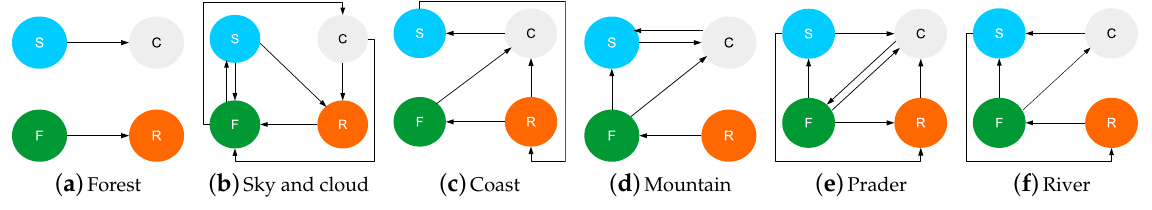
Figure 16. Evolutionary texture causal relationship graphs resulted for each